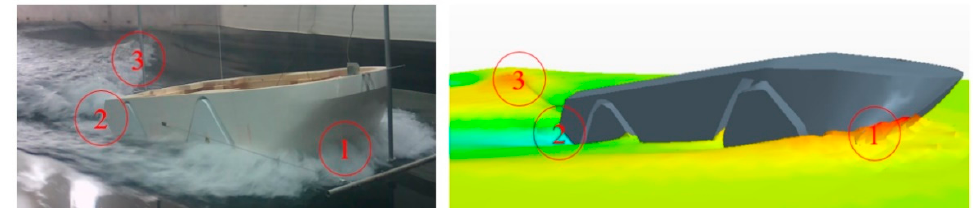
Figure 10. Comparison of the surface wave between EFD and CFD.